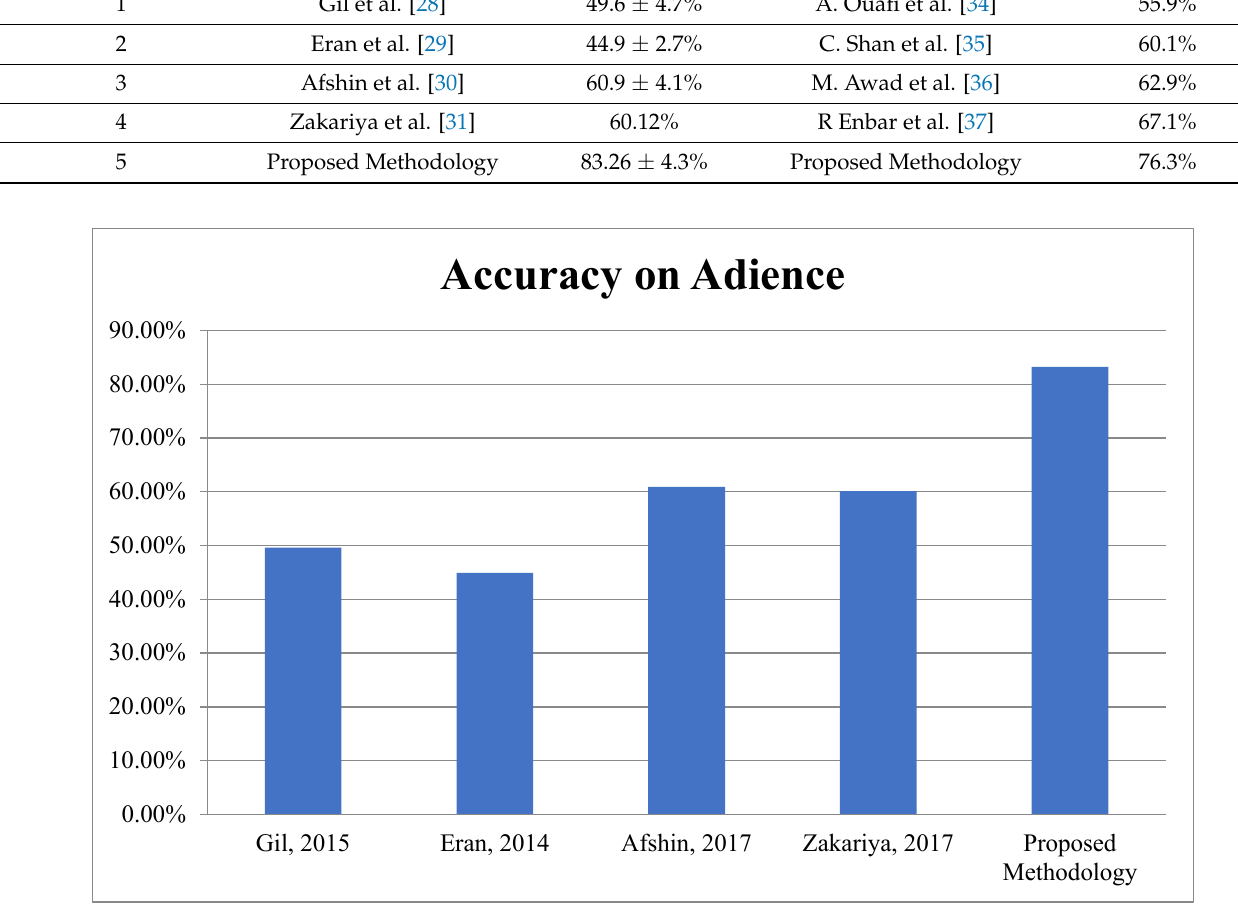
Table 6. Accuracy Comparison for Age Classification on Adienceand IOG. Sr. No.